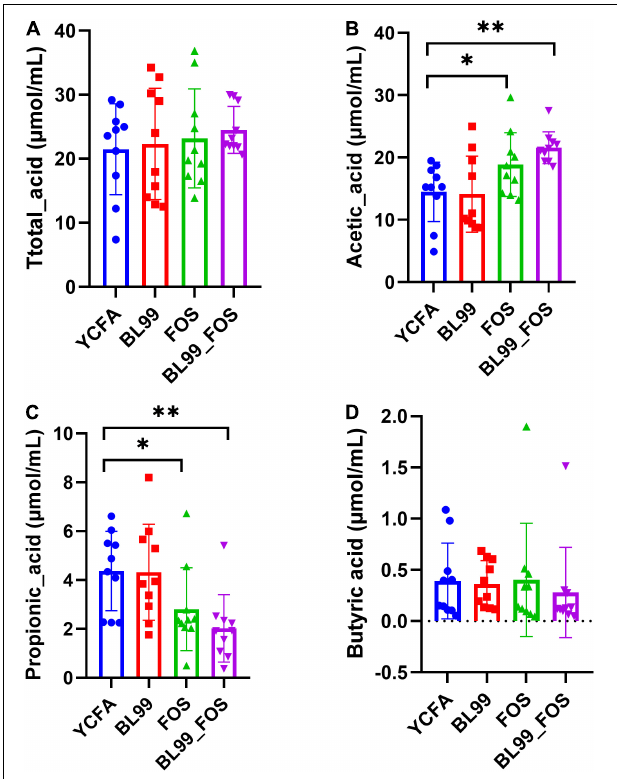
FIGURE 2 | Total acid (A) , acetic acid (B) , propionic acid (C) , and butyric acid (D) contents in different groups. Statistical significance was calculated by one-way ANOVA with LSD test, * P < 0.05, ** P < 0.01, and *** P < 0.001 were considered with significant